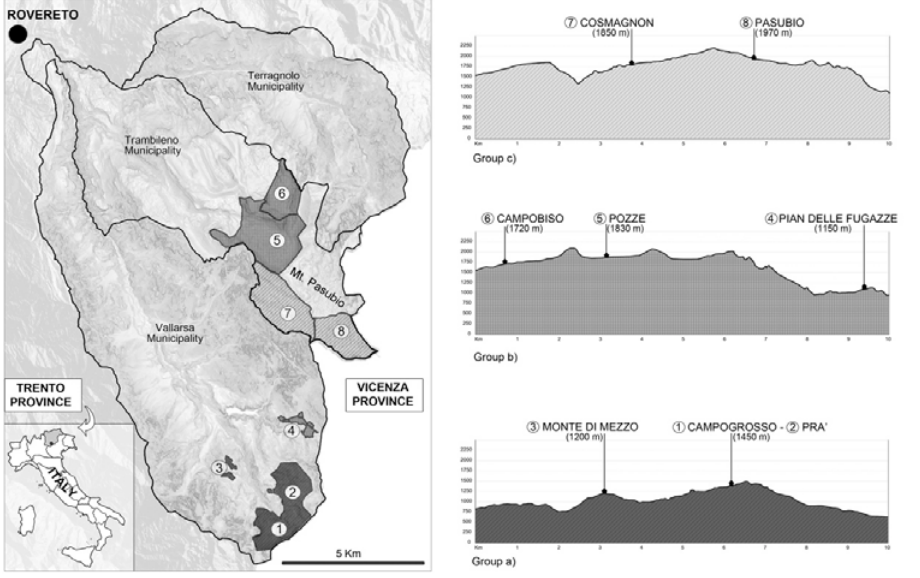
Figure 1. The Pasubio area is in southern Trentino (Italy). The mountain pastures studied, higlighted in grey, occupy the central part of the Pasubio massif and the southermost part of the Vallarsa valley. (1 Campogrosso; 2 Pra; 3 Monte di Mezzo; 4 Pian delle Fugazze; 5 Pozze; 6 Campobiso; 7 Cosmagnon; 8